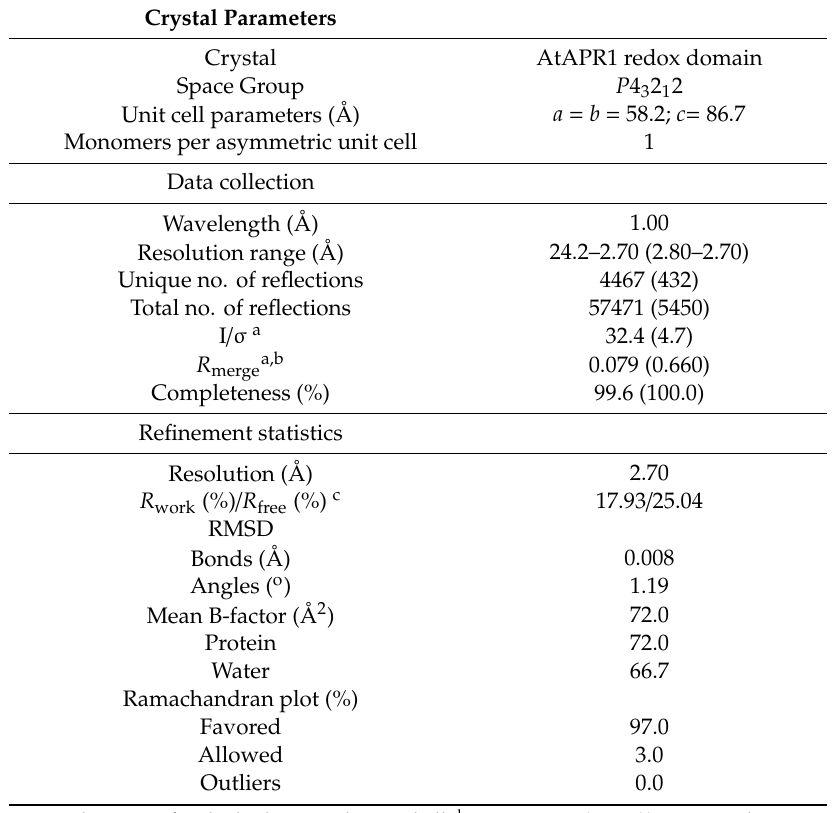
Table 1. Data collection and refinement statistics of AtAPR1 redox